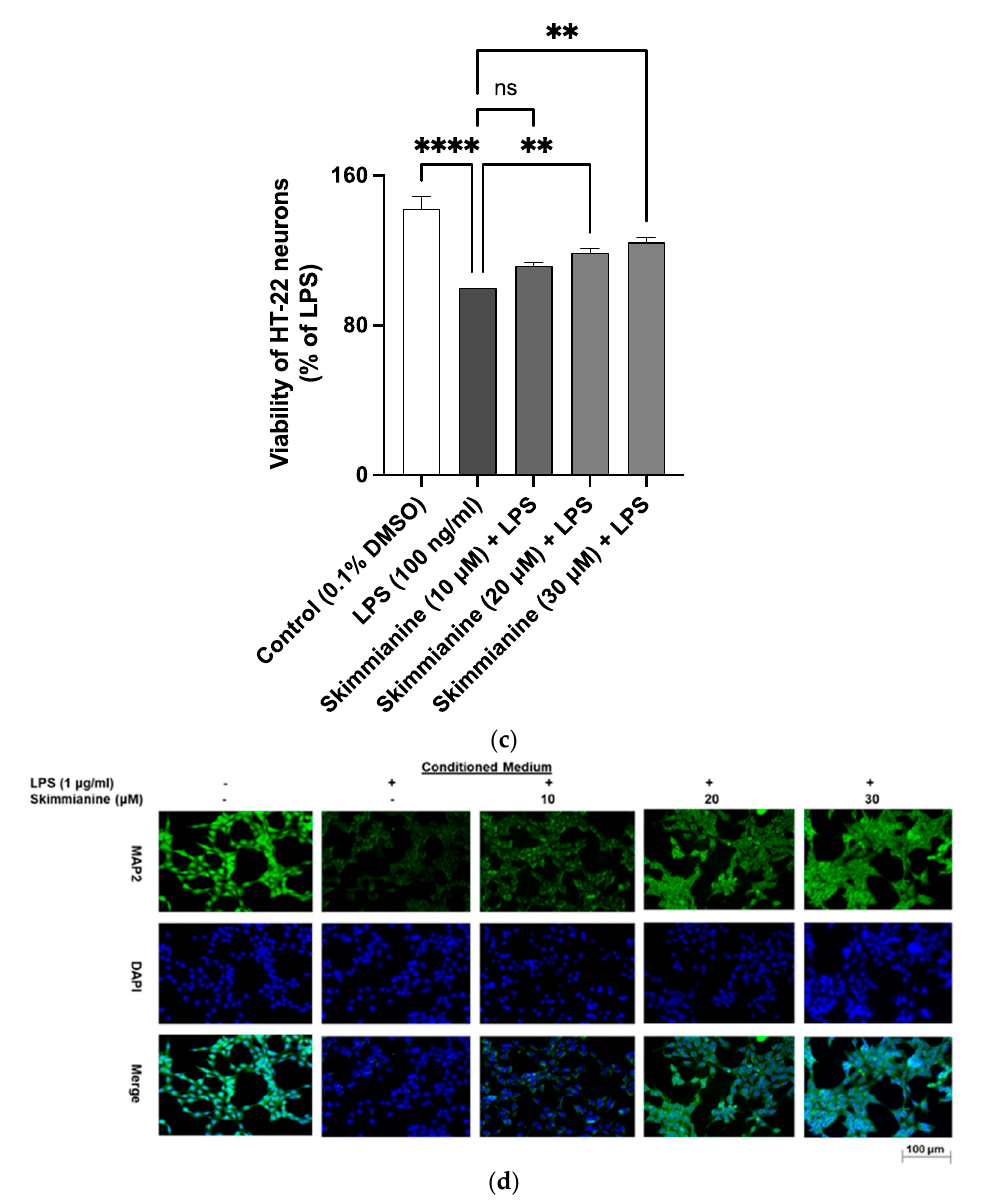
Figure 10. Skimmianine reduced neuroinflammation-mediated neurotoxicity in HT22 hippocampal neuronal cells. Cultured BV-2 cells were pre-treated with skimmianine for 30 min and stimulated with LPS (1 μ g/mL) for 24 h. An ELISA was used to analyse the levels of nitrite ( a ) and TNF α ( b ) in conditioned media. An MTT viability assay showing the effect of incubation of conditioned media on the viability of HT-22 neurons ( c ). Immunofluorescence imaging showing the effect of condi- tioned media on MAP-2 expression in HT-22 cells ( d ). Values are mean ± SEM of at least three inde- pendent experiments. A statistical analysis was carried out using a one-way ANOVA with a post hoc Dunnett’s test. ** p < 0.05; *** p < 0.001; in comparison with LPS stimulation.